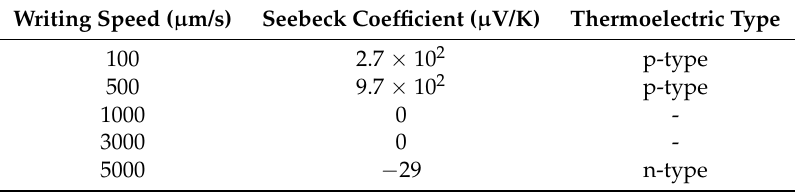
Table 1. Seebeck coefficients of micropatterns printed at various writing speeds.